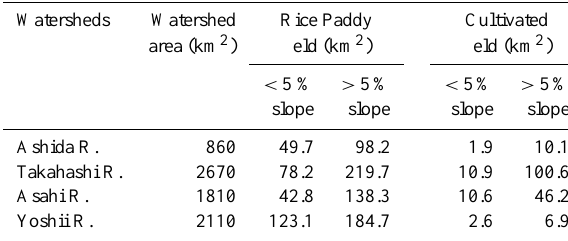
Table 1. The total area of agricultural land-use.